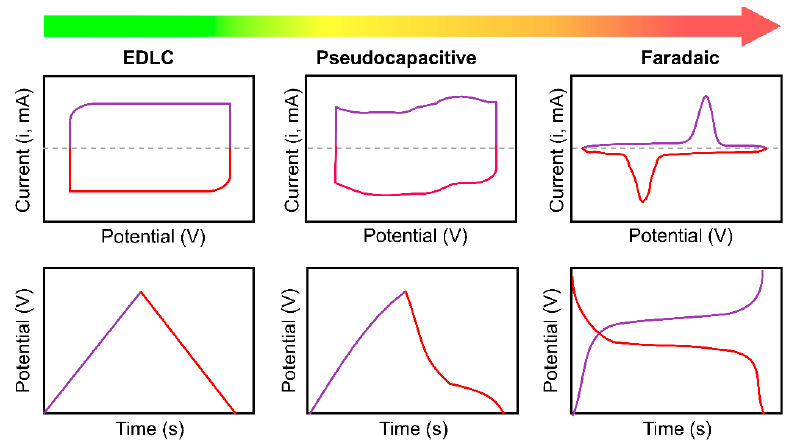
Figure 3. Schematic cyclic voltammograms and corresponding charge-discharge curves of electric- double-layer capacitor (EDLC), pseudocapacitor, and faradaic-type